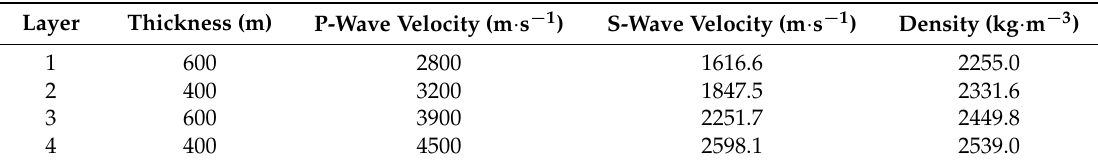
Table 1. Parameters of model 1.